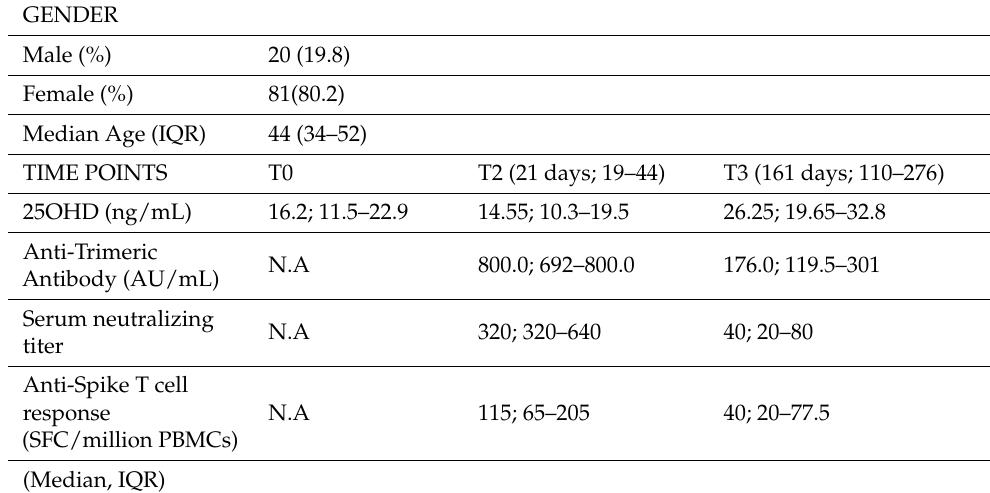
Table 1. Subjects’